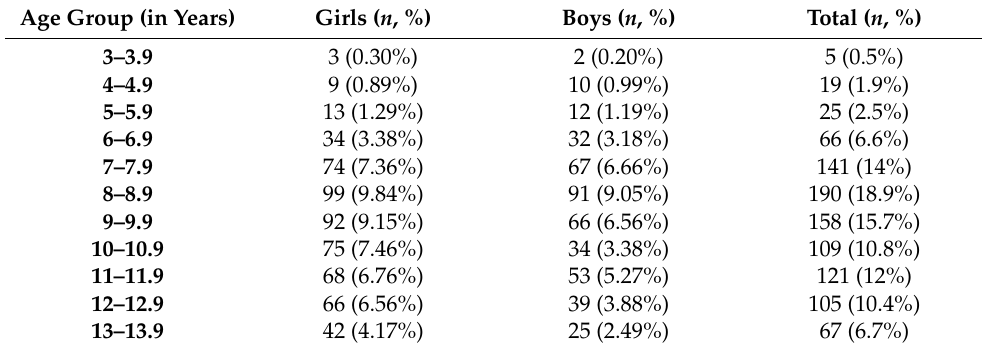
Table 1. Distribution of the patients in different chronological age